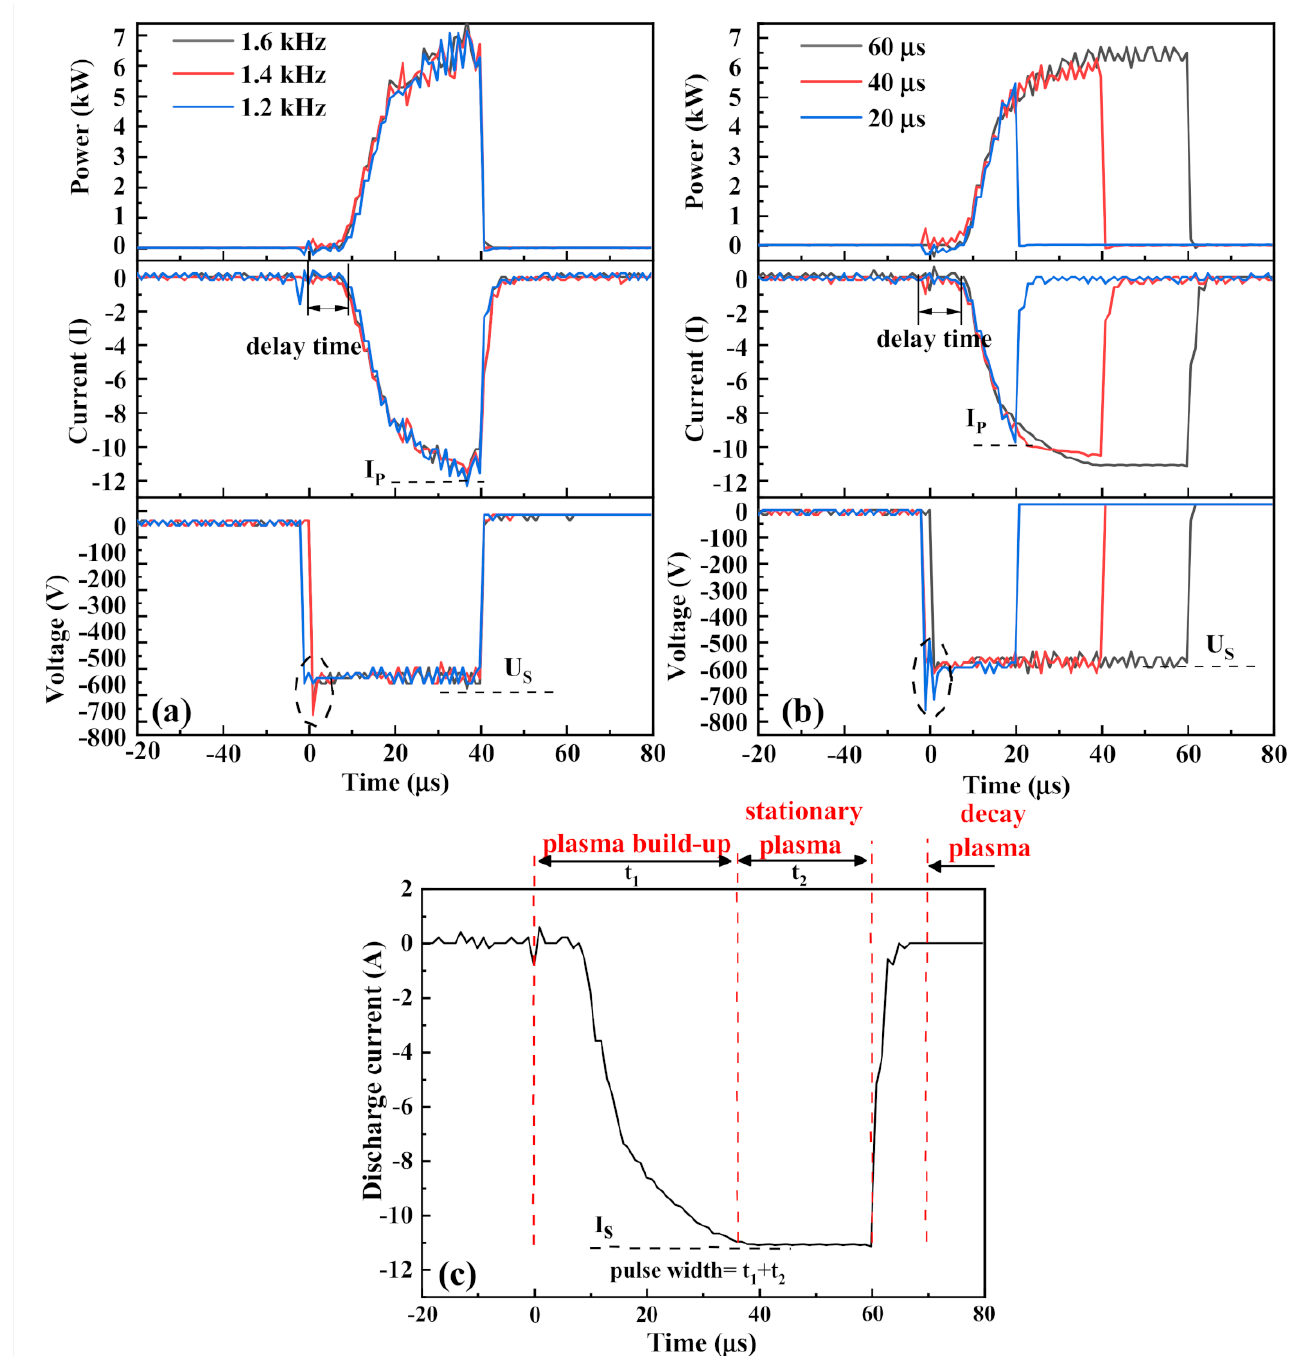
Figure 2. Voltage and discharge current (I–V) oscillogram in HiPIMS at ( a ) different frequencies (1.2–1.6 kHz); ( b ) different pulse widths (20–60 µ s); and ( c ) three discharge current operation regimes at 60 µ s, where pulse width ( τ ) = plasma build-up time (t 1 ) + stationary plasma time (t 2